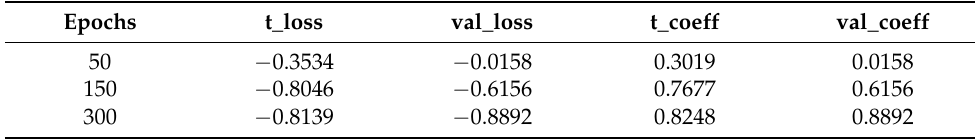
Table 3. Results for the model with Jaccard loss.